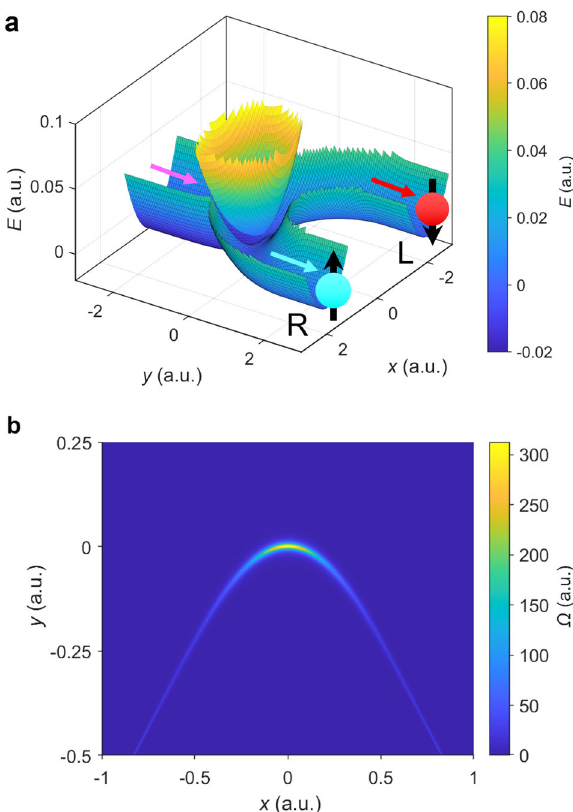
Fig. 1 The potential surfaces and Berry curvature for the model Hamiltonian (Eq. (7)). a The adiabatic potential surfaces. On the ground state, the incoming channel (marked by the magenta arrow) is in the direction y → − ∞ at x = 0, the two outgoing channels (L and R, marked by the red and blue arrow according to their spin preferences) are in the direction y → + ∞ at x = ± r 0 . Nuclear wave packets associated with the spin-up electronic states prefer channel R while nuclear wave packets associated with spin-down electronic states prefer channel L. The perturbed CI is at x = 0, y = 0. b The Berry curvature Ω of the ground adiabatic surface around the intersection point. Here the model parameters (de fi ned in Eq. (8)) are: A = 0.02, ω = 0.01, M = 10 3 , ϵ 1 = 2.5, ϵ 2 = 2.5, r = 2, μ = 10 − 3 , λ = 2 × 10 − 4 (all in atomic units). Note the avoided CI 0 becomes a true CI when λ = 0 (Supplementary Fig.